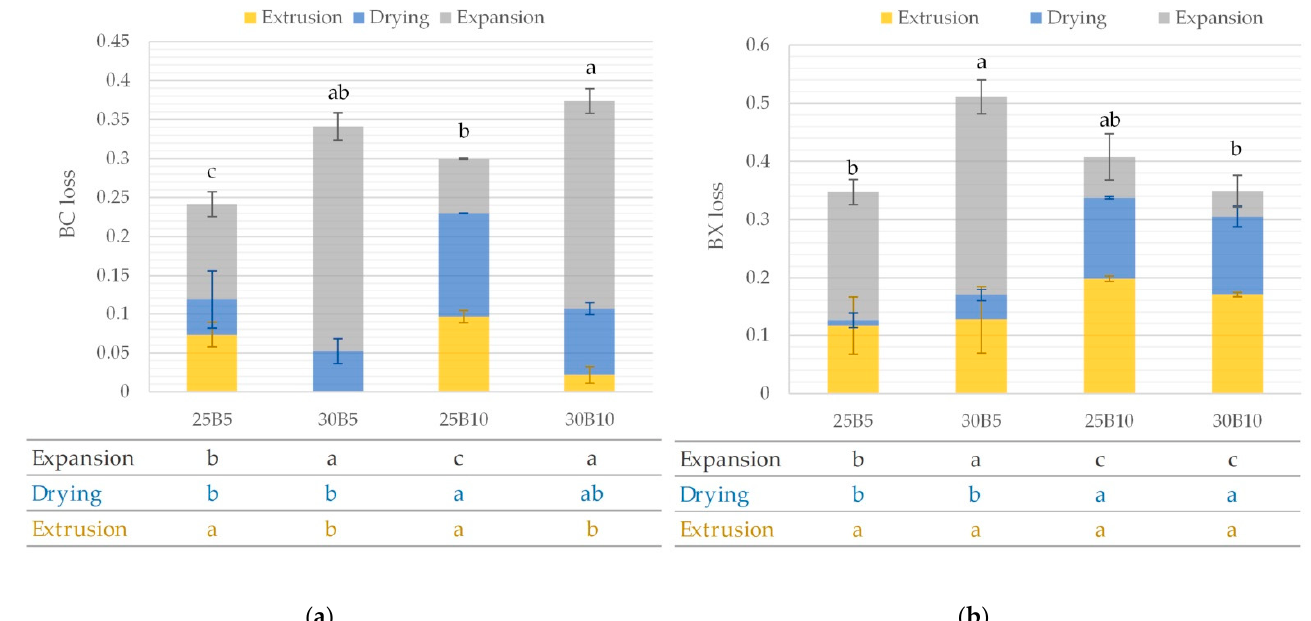
Figure 7. Mean values (and standard deviations) of ( a ) betacyanins (BC) and ( b ) betaxanthins (BX) loss due to extrusion, drying, and expansion for each snack. The table contains the letters representing the homogeneous groups established by ANOVA ( p < 0.05) for betalain losses at each stage of production.